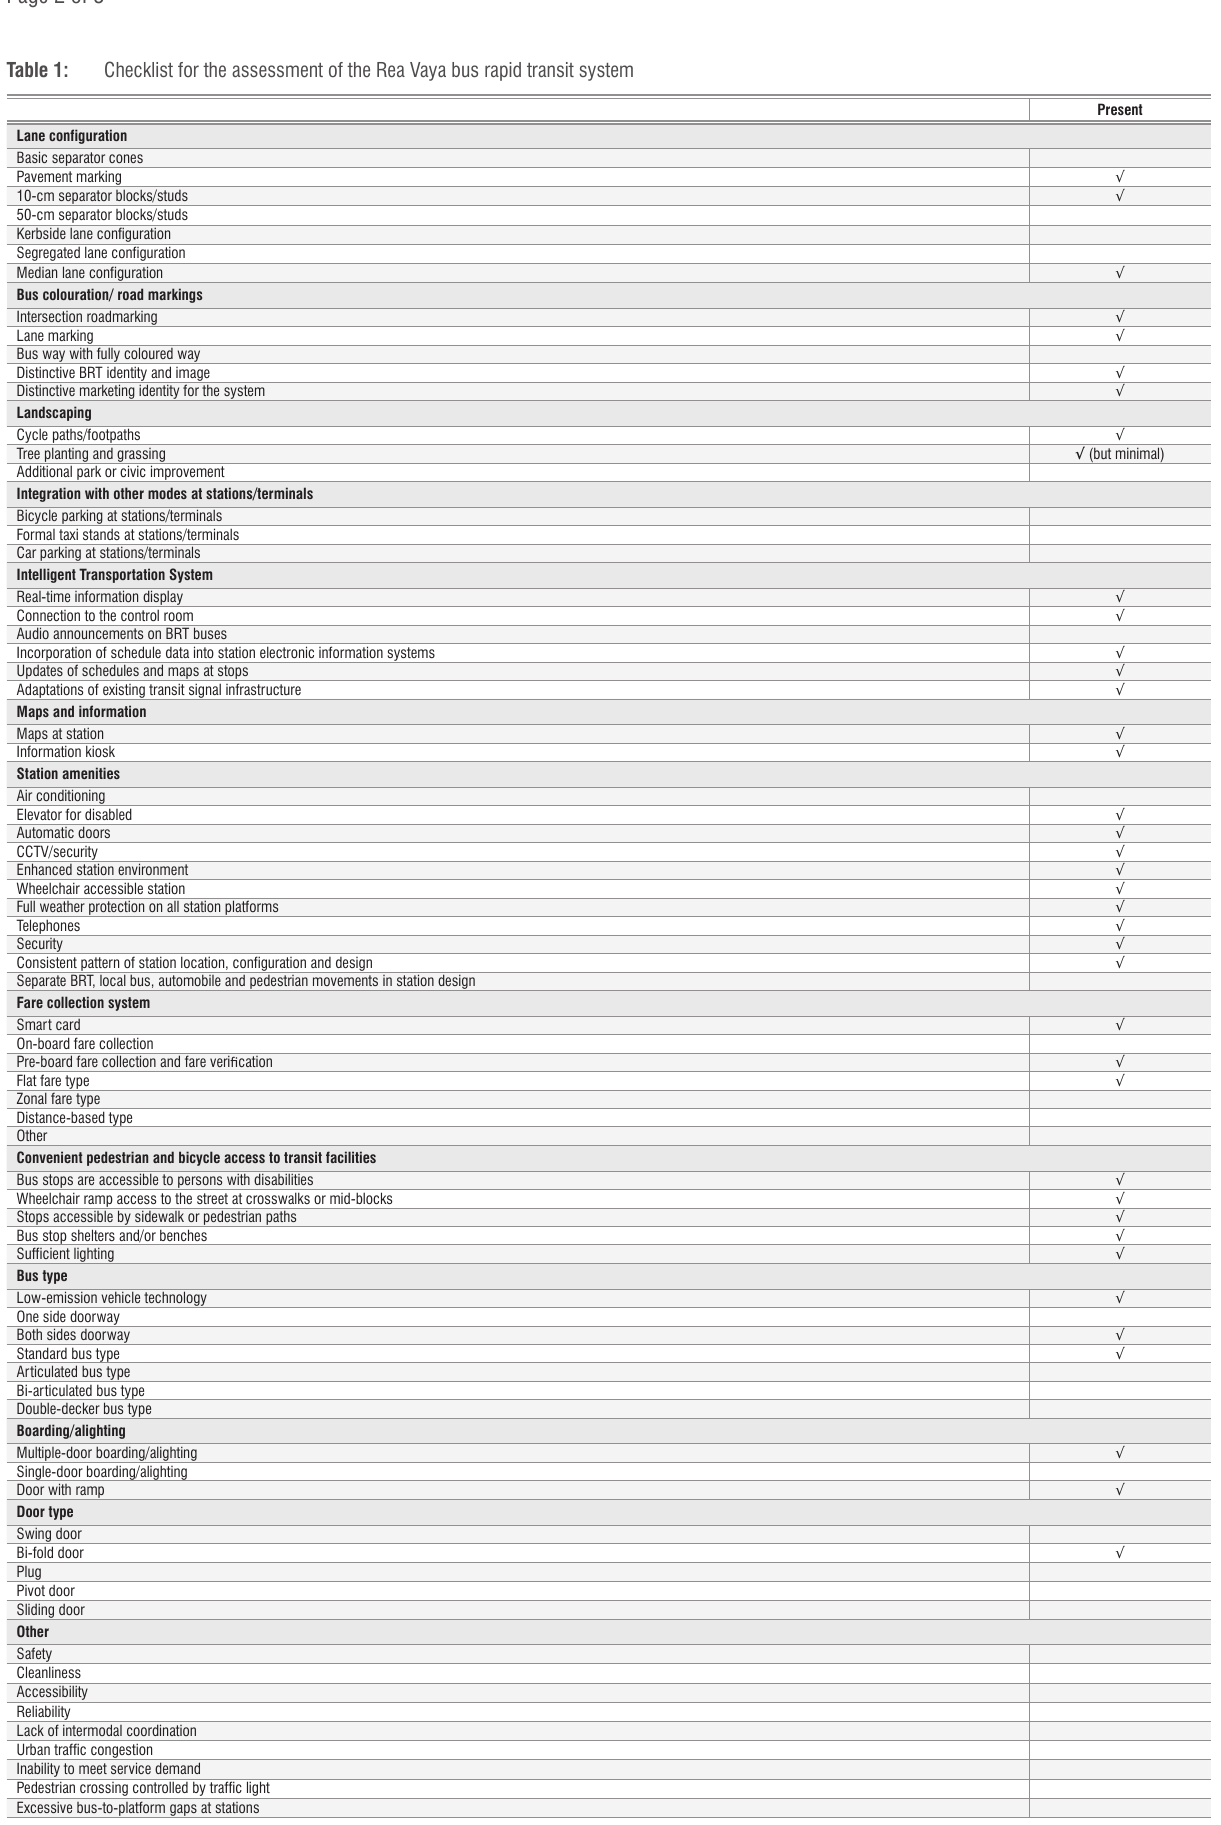
Reliability Lack of intermodal coordination Urban traffic congestion Excessive bus-to-platform gaps at